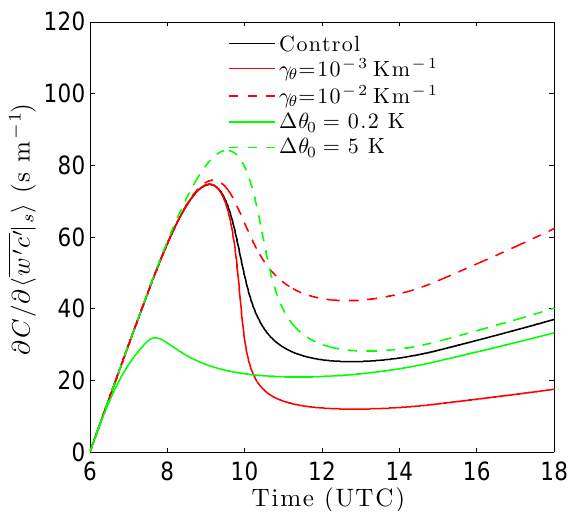
Fig.5. TimeevolutionofthesensitivityoftheCO 2 mixingratiototheCO 2 surfacefluxforthesameboundarylayerspresentedinFig. 3. Fig. 5. Time evolution of the sensitivity of the CO to the CO 2 surface flux for the same boundary layers presented in Fig. 3.